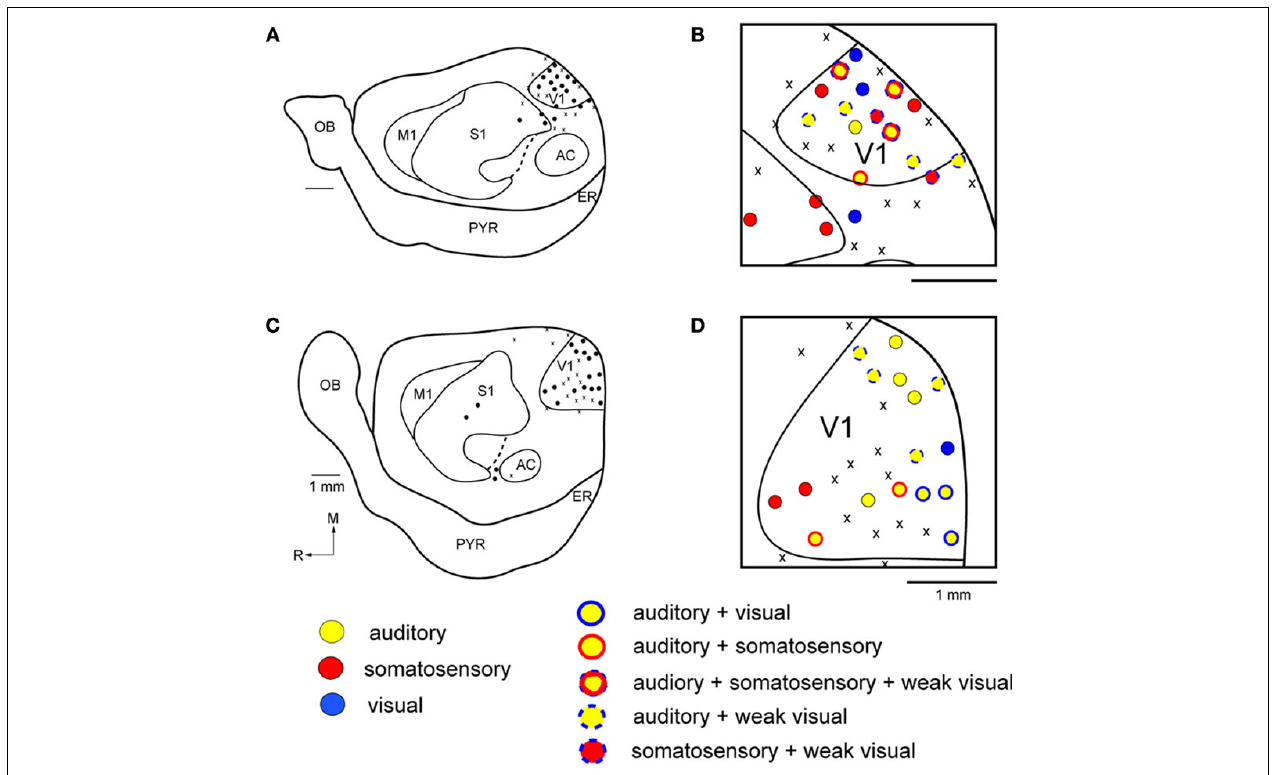
FIGURE 3 | Functional Organization of V1 in Gnat − / − Mice . Reconstructions of multi-unit electrophysiological recordings from 2 Gnat − / − mice are shown in which boundaries of primary sensory areas, as determined by myeloarchitecture, are denoted by black lines and recording sites are denoted by black dots indicating the location of recording sites (A,C) . Enlargements of the recording sites in visual cortex are shown in which recording sites are denoted by color coded dots indicating the sensory